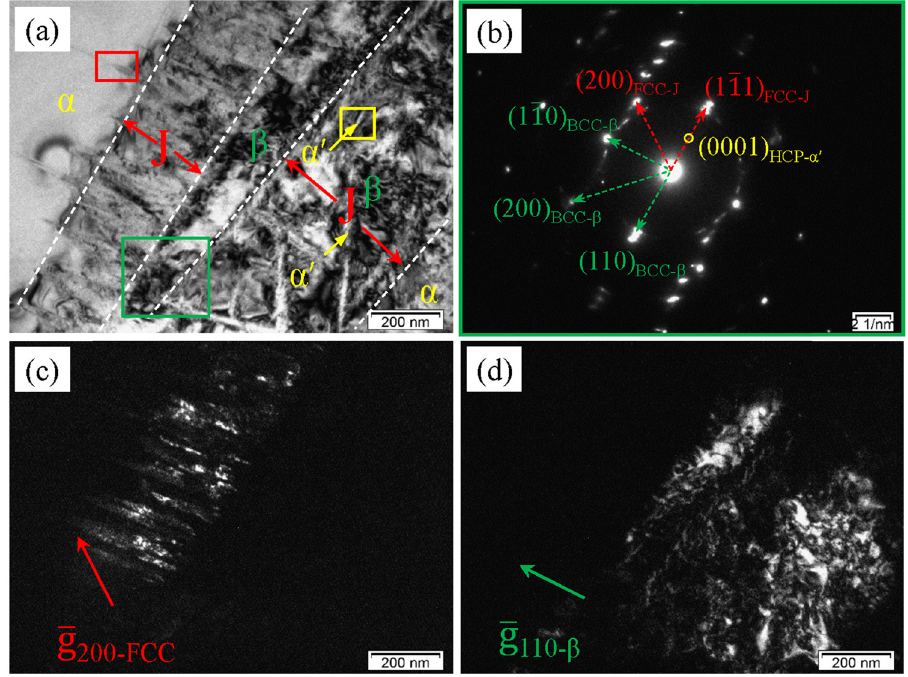
Figure 5: TEM micrographs of the disordered region in the forged Ti80 alloy: ( a ) bright - fi eld image, ( b ) the SAED pattern in blue rectangle of ( a ) , and ( c ) and ( d ) dark - fi eld image of ( a )